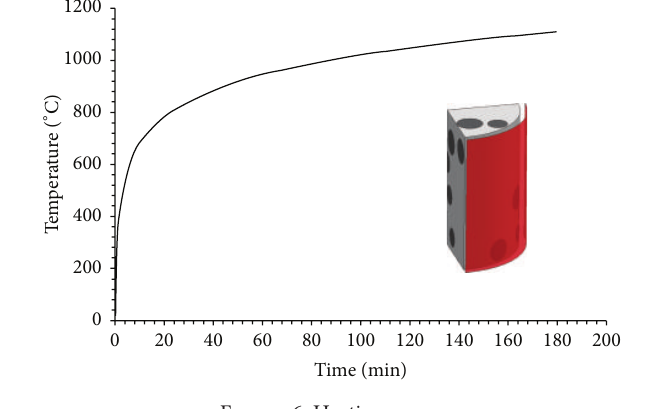
Figure 6: Heating curve.